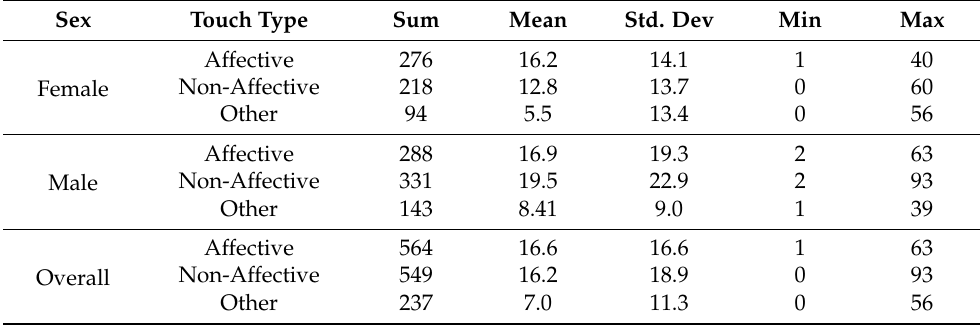
Table 1. Descriptive Overview of Total Received Touches (grouped by Intention